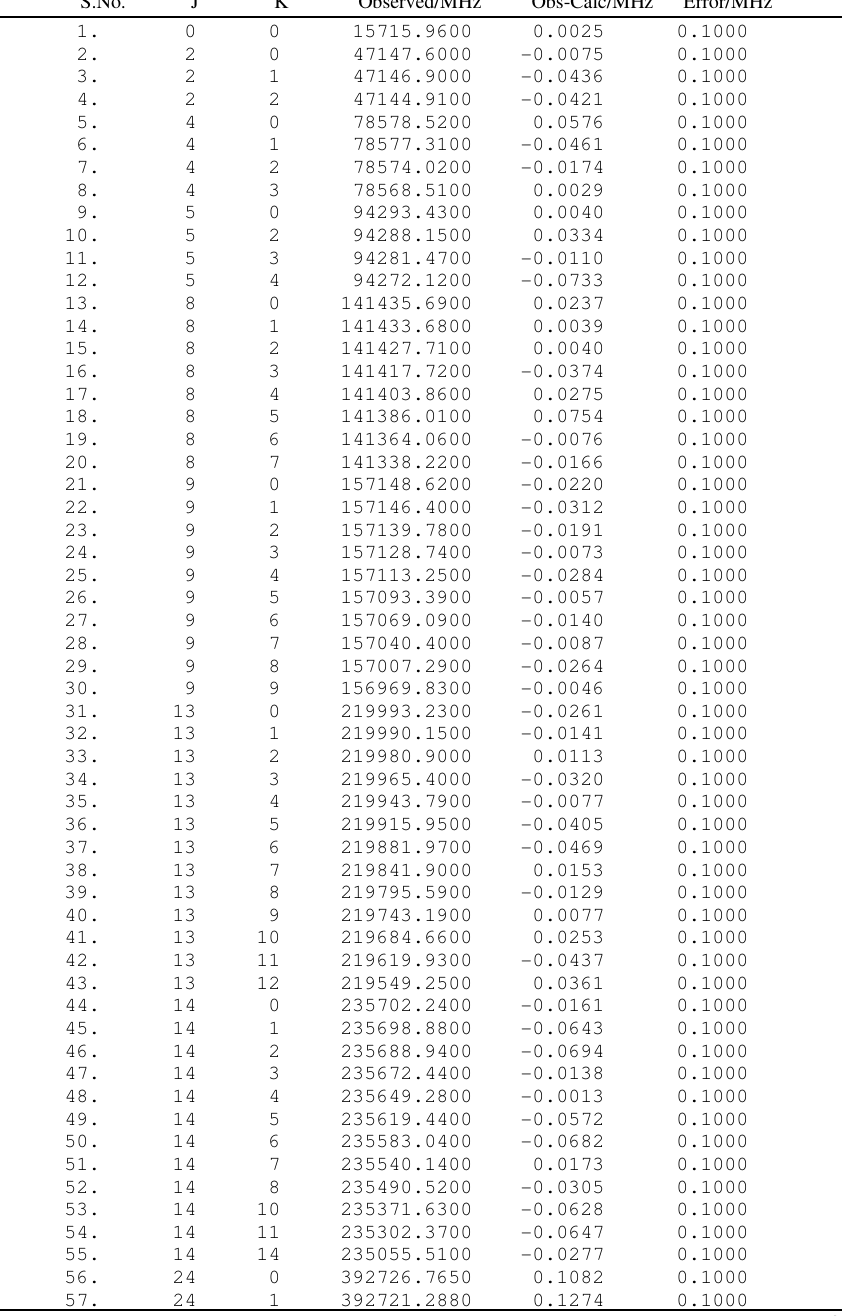
CN in the grounds state 22,24 . 3